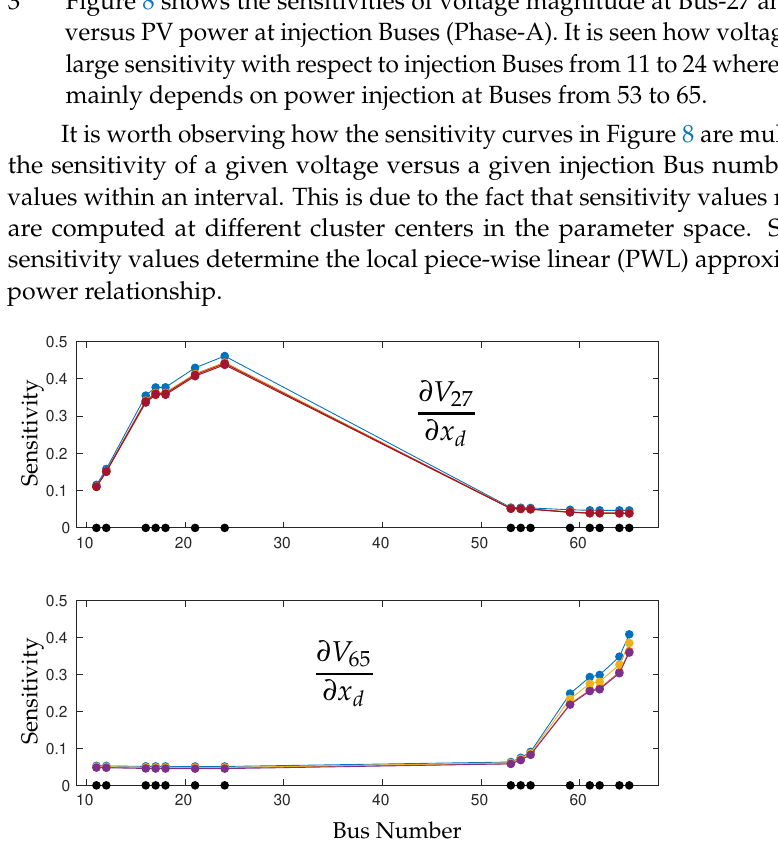
Figure 8. Sensitivities of voltage at Bus-27 and Bus-65 versus PV power at injection Buses.